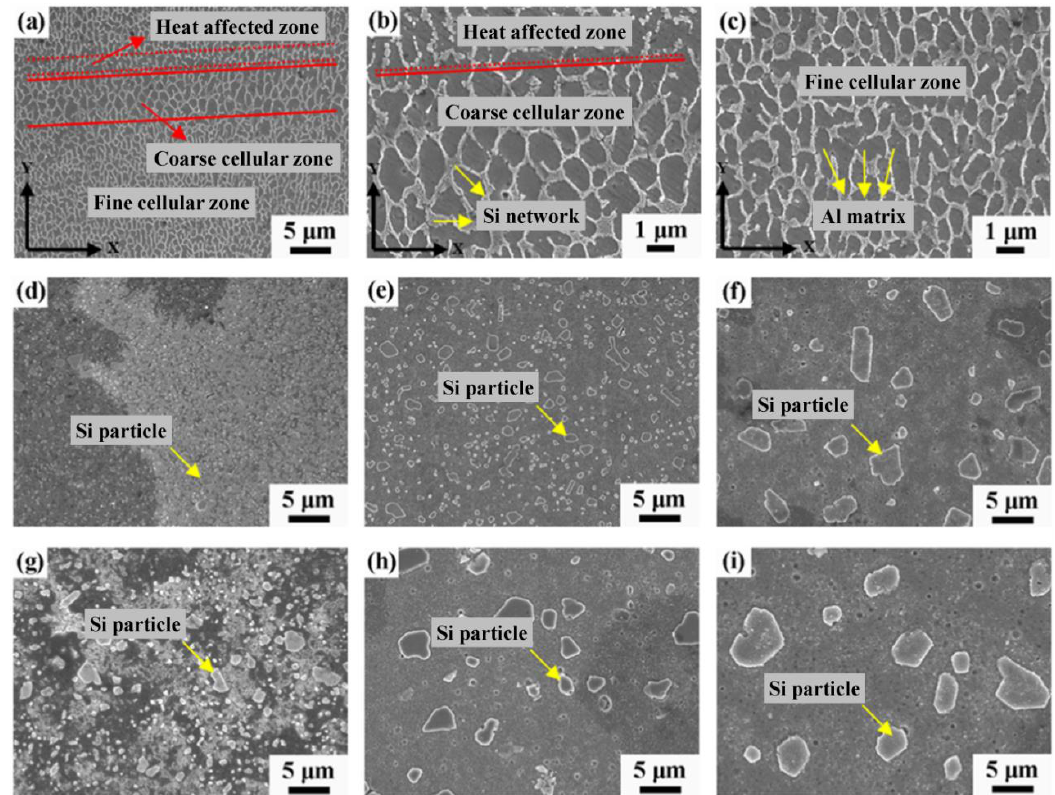
Figure 9. Secondary electron micrographs showing the microstructure of as-built and heat-treated AM AlSi10Mg. ( a – c ) Represent the microstructure of the as-built samples in different zones and at different magnifications. ( d – i ) Represent the microstructure of the samples after different heat treatments: ( d ) 450 °C for 2 h; ( e ) 500 °C for 2 h; ( f ) 550 °C for 2 h; ( g ) 450 °C for 2 h + 180 °C for 12 h; ( h ) 500 °C for 2 h + 180 °C for 12 h; ( i ) 550 °C for 2 h + 180 °C for 12 h. (Adapted from reference [38]).